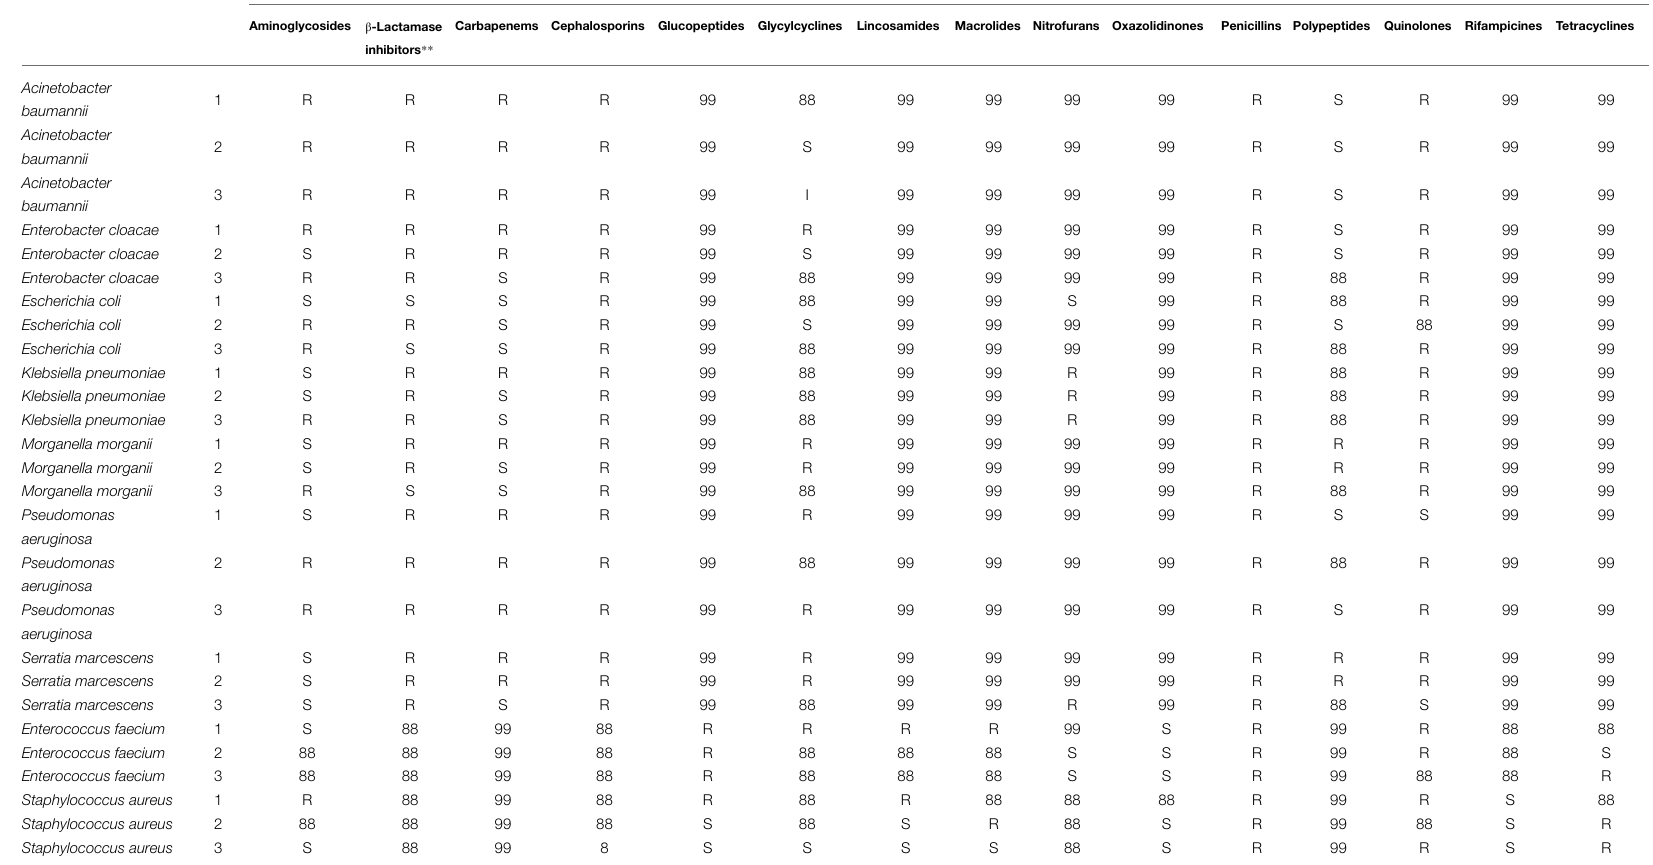
TABLE 1 | Bacterial susceptibility profile of each class of antimicrobials tested in two hospitals in the city of Pelotas, Brazil, 2018–2019. Bacteria/Isolates Classes of antimicrobials